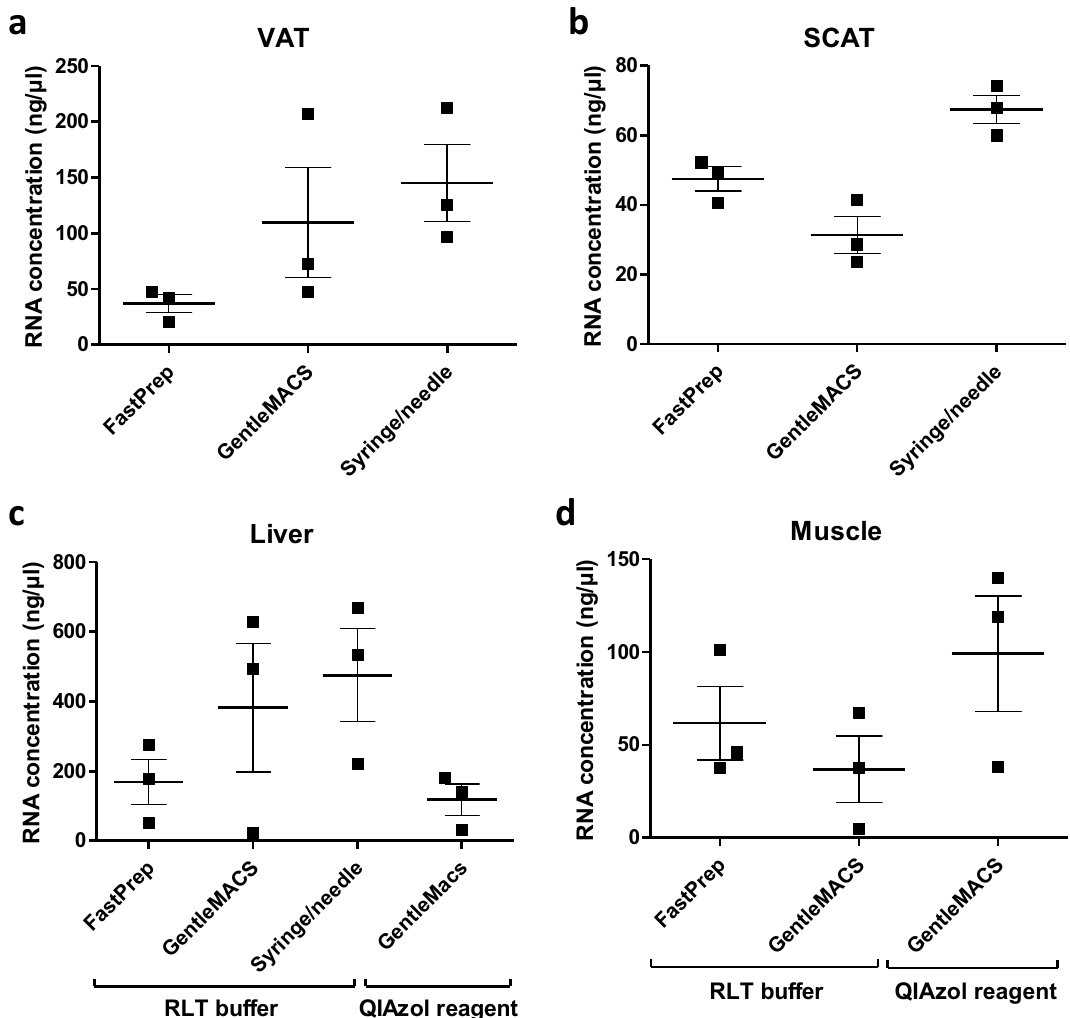
Figure 1. RNA concentration after extraction with different homogenization buffers and methods. RNA concentration was measured using Nanodrop Spectrophotometer at 260 nm. For each condition tested, 20 mg liver and muscle, or 50 mg adipose tissues were subjected to different homogenization buffers and methods. At the end of the extraction protocol, RNA was eluted in 30 µL buffer. Mean values ± SEM are shown for VAT ( a ), SCAT ( b ), liver ( c ), and muscle ( d ). VAT visceral adipose tissue, SCAT sub-cutaneous adipose tissue. FastPrep for FastPrep-24 Instrument, GentleMACS for GentleMACS